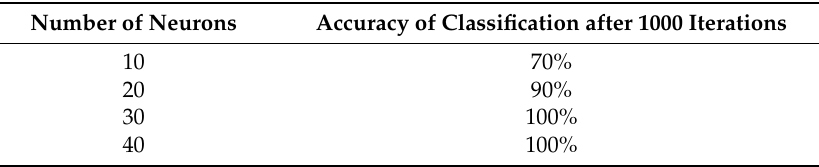
Table 5. Number of hidden layer neurons.